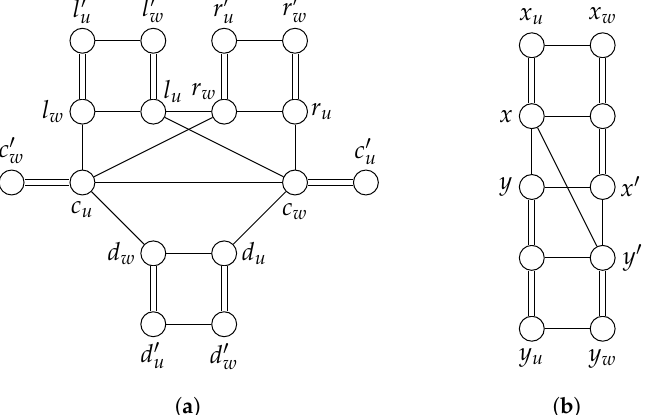
Figure 3. Gadgets. Double lines denote edges with ears. ( a ) an AND gadget; ( b ) an edge